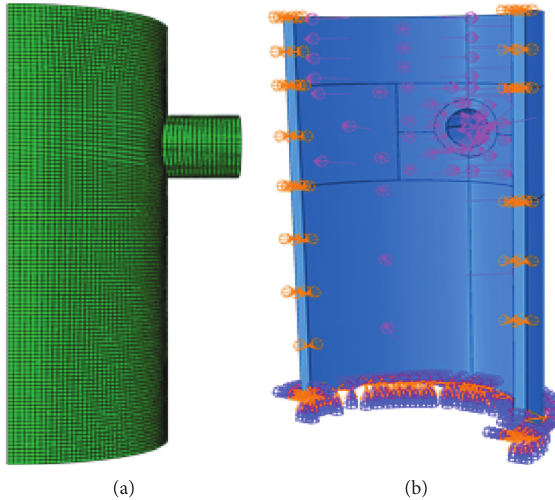
Figure 6: (a) Finite element mesh model of the RPV. (b) RPV model with applied AOO PTS loads and boundary